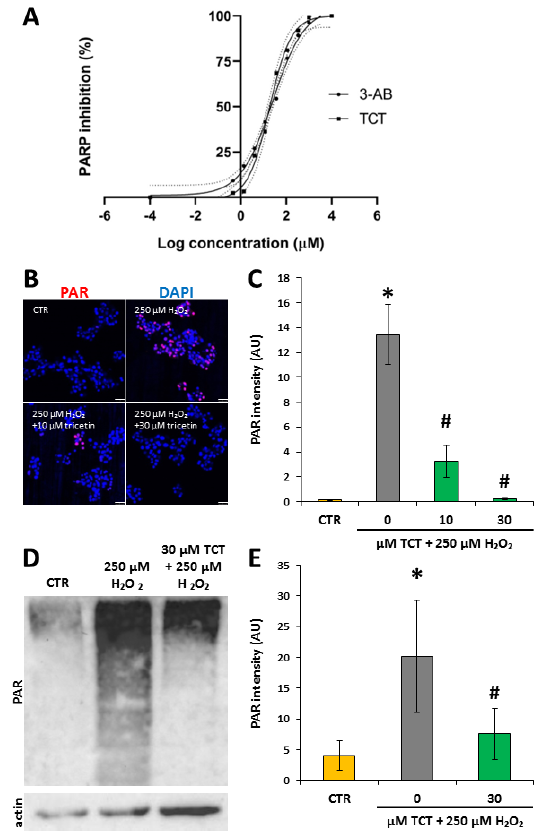
Figure 3. Tricetin inhibits PARP in enzyme activity assays and in isolated acinar cells. Tricetin (TCT) inhibits PARP1, as measured with a PARP activation kit ( A ). Primary acinar cells were pretreated with 10 μ M or 30 μ M TCT for one hour and then treated with 250 μ M hydrogen peroxide for 7.5 min. Immunocytochemical staining of PAR polymer was evaluated with confocal microscopy followed by image analysis with ImageJ software (scale bar 50 μ m) ( B , C ). PAR polymer, the product of PARP enzymes, was detected in Western blots and signals were quantitated with ImageLab software and were normalized to actin signal intensities ( D , E ). Error bars represent the SD of three (IF) or four (WB) independent experiments. Statistical analysis was performed with one-way ANOVA test followed by Tukey’s post hoc test. Stars (*) indicate significant ( p < 0.05) H 2 O 2 -induced PARylation compared to the control. Hashtags (#) indicate significant ( p < 0.05) reduction of the PAR signal in TCT-treated samples versus H 2 O 2 -treated cells.